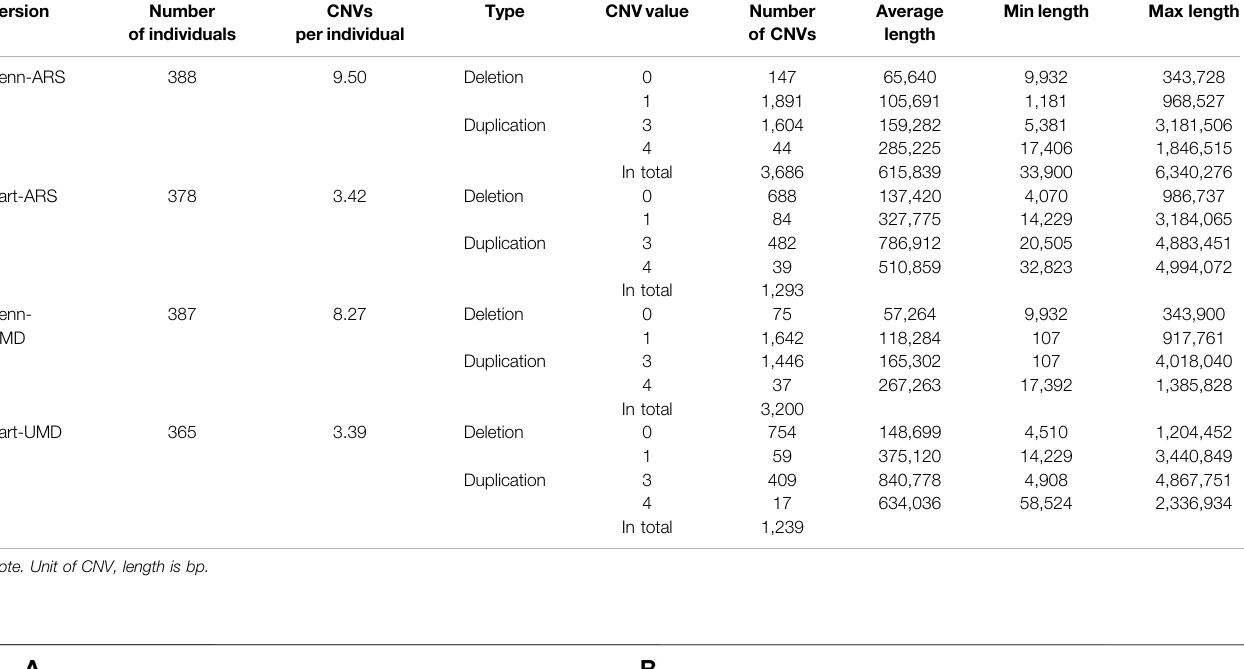
Frontiers in Genetics |